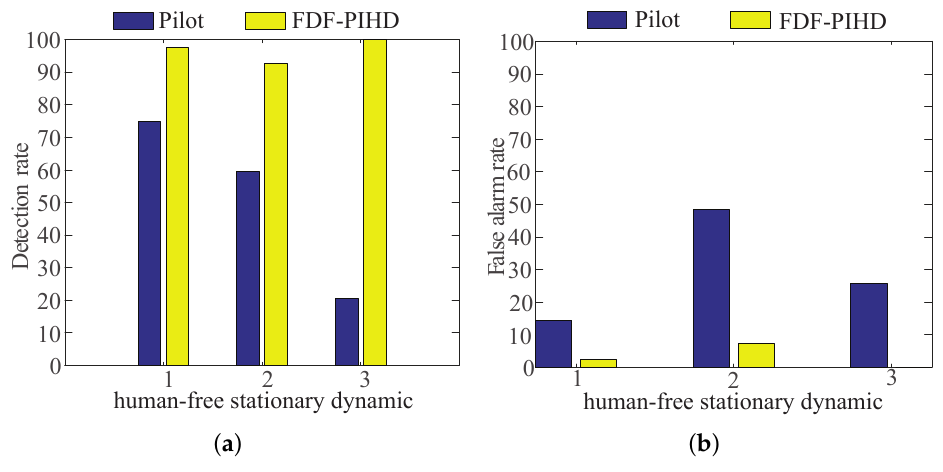
Figure 8. Comparison diagram of detection rate and false alarm rate. ( a ) online human-free fingerprint; ( b ) online stationary target